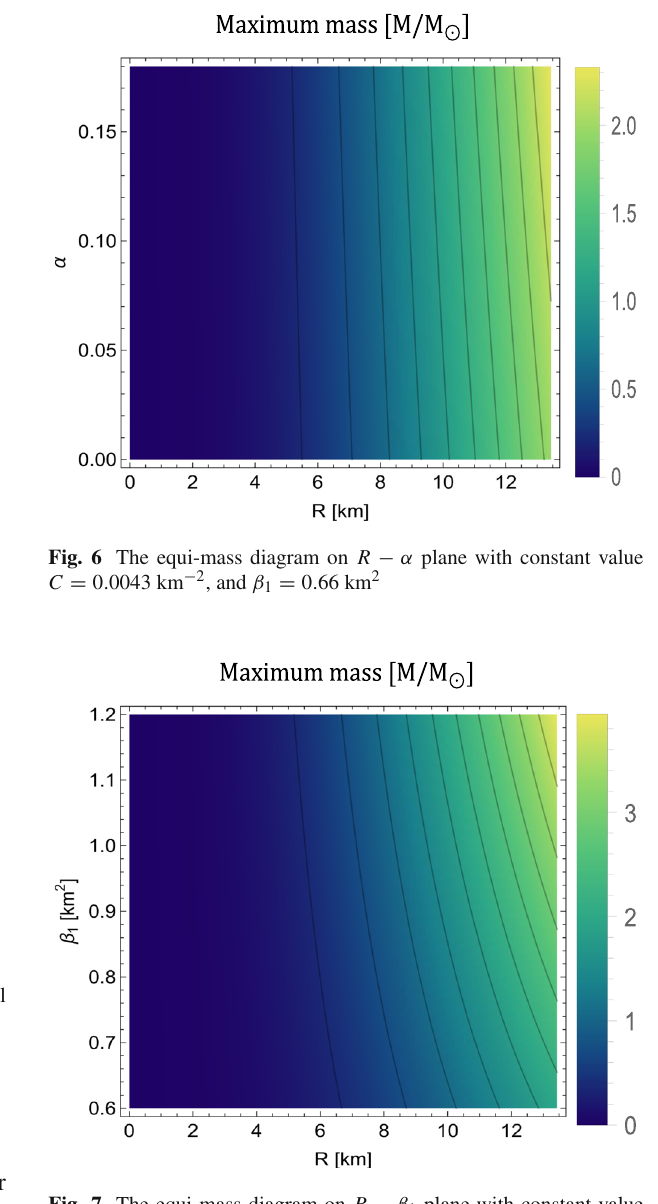
Fig. 7 The equi-mass diagram on R − β 1 plane with constant value C = 0 . 0043 km − 2 , and α = 0 .